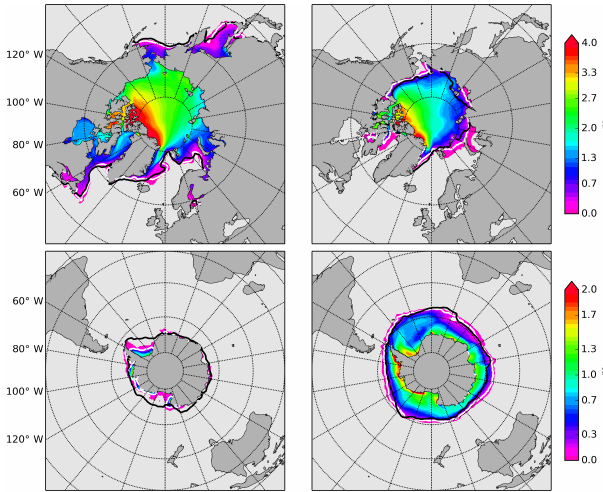
Figure 7. The simulated mean ice thickness distribution (m) in the Northern (top) and Southern (bottom) hemispheres in March (left) and September (right).